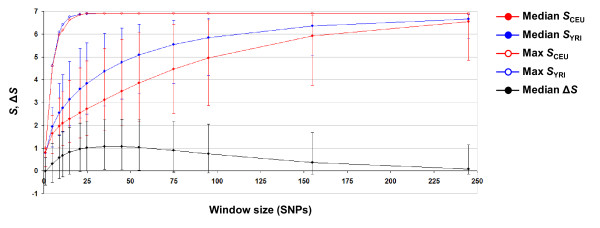
Relationship between window size and entropy for HapMap data. Filled circles represent medians of S distribution for CEU (red), YRI (blue) and the difference between them (ΔS, black) with 95% confidence intervals. Open circles represent maximum entropy for both CEU and YRI populations.